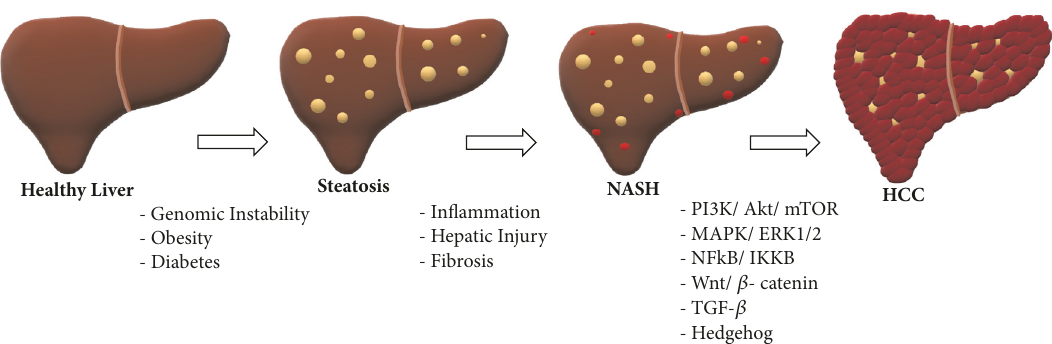
Figure 1: Development of NASH and HCC from healthy liver.